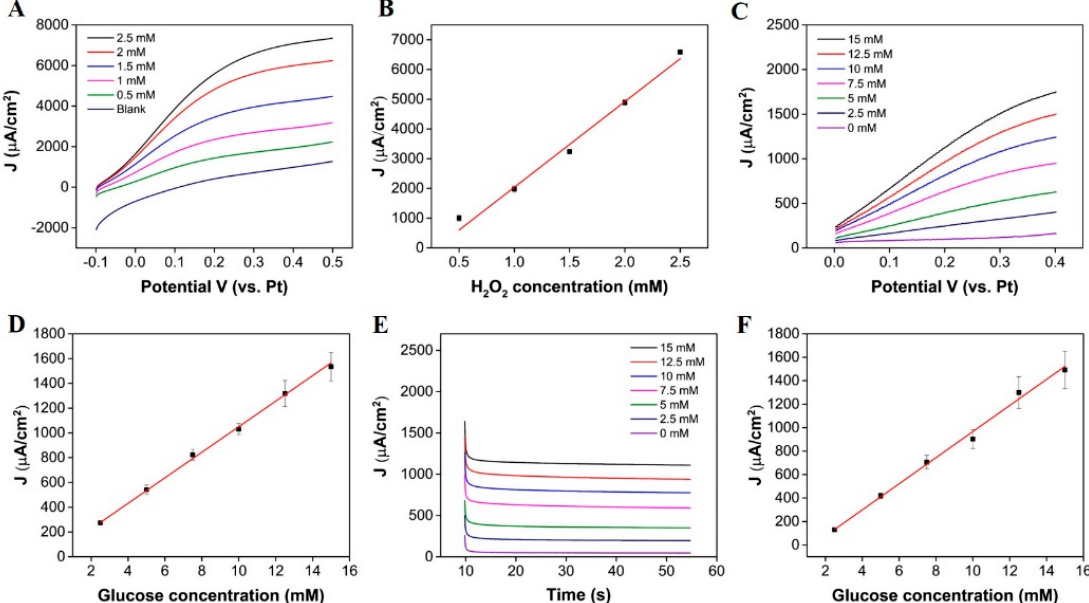
Figure 4. ( A ) LSV obtained at a scan rate of 50 mVs − 1 in increasing concentrations of H 2 O 2 at the Au/Pt-B/o-PD/ β -cyclodextrin surface, ( B ) corresponding calibration obtained from background subtracted data at 0.25 V, ( C ) LSV obtained at a scan rate of 50 mVs − 1 from 0 to 0.4 V in increasing glucose concentrations in 50 mM PB solution (pH 7.4), ( D ) corresponding calibration obtained from background subtracted data at 0.25 V, ( E ) i-t curves for the chronoamperometric response of the biosensor to increasing glucose concentrations in 50 mM PB (pH 7.4), and ( F ) the resulting calibration curve.